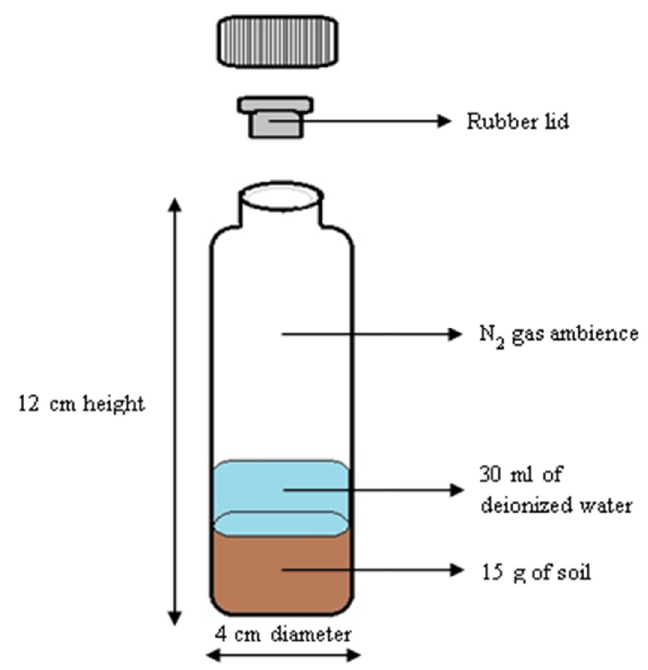
Figure 2. Anaerobic incubation.